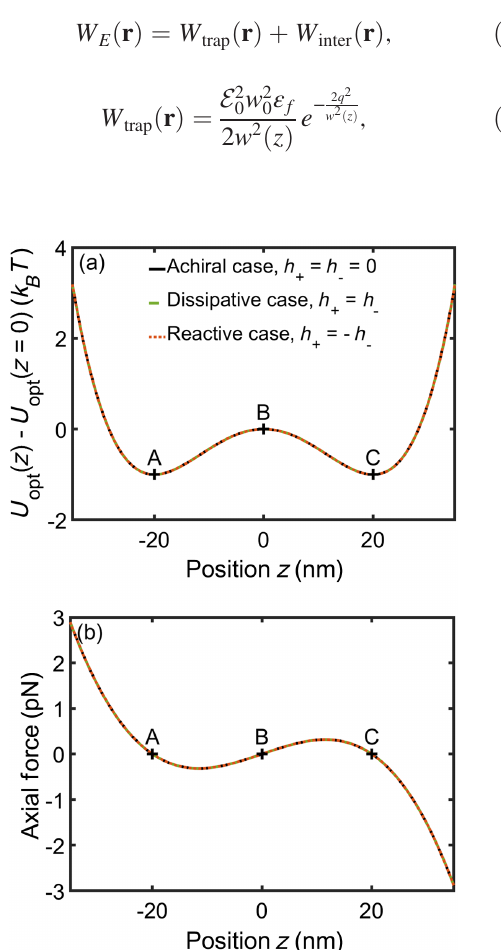
ð r Þ ¼ FIG. 3. (a) Bistable optical potential energy U opt − Re ½ α (cid:3) W ð r Þ displaying the two local minima at z z E A and C separated by the barrier at z B . The electric dipolar polarizability α associated with an achiral ( χ ¼ 0 ) gold (Au) nanosphere of radius R ¼ 20 nm is calculated using Au tabulated optical data mea- sured at an illumination wavelength of 785 nm and the Clausius- ≡ 0 in this case. Mossotti relations of Appendix B with κ Au (b) Corresponding optical achiral force field F α ¼ Re ½ α (cid:3) ∇ W E ð r Þ ð r Þ is drawn in the waist region. This double-well profile in U opt generated with the polarization settings h þ ¼ h − ¼ 0 ; δθ ¼ 0 . 9989 × π = 2 ; δ ¼ − π . Superimposed in (a) and (b) is the achiral potential energy recalculated with the polarization settings that lead to reactive and dissipative chiral environments. These settings are h þ ¼ 0 . 05 ¼ − h − ; δθ ¼ 0 . 8990 × π = 2 ; δ ¼ − π for the reactive case and h þ ¼ 0 . 0017 ¼ h − ; δθ ¼ π = 2 ; δ ¼ π = 2 for the dissipative one. As seen, these polarization settings do not modify the achiral potential energy surface inside the optical trap. The distance between the two local wells located at z A < 0 and z C > 0 from both sides of the waist barrier positioned at z B ¼ 0 is noted Δ l in the main